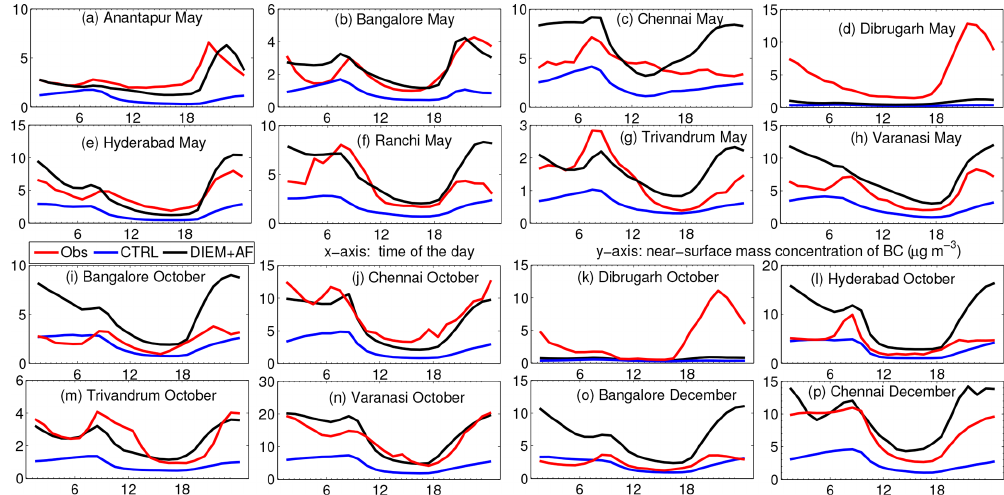
Figure 2. Comparison between the observed monthly-mean diurnal cycle of NSBC and the model simulations in the CTRL and DIEM+AF configurations, over the different ARFI observational stations across the country. The red, blue and black contours correspond to observations and the CTRL and DIEM+AF simulations, respectively.